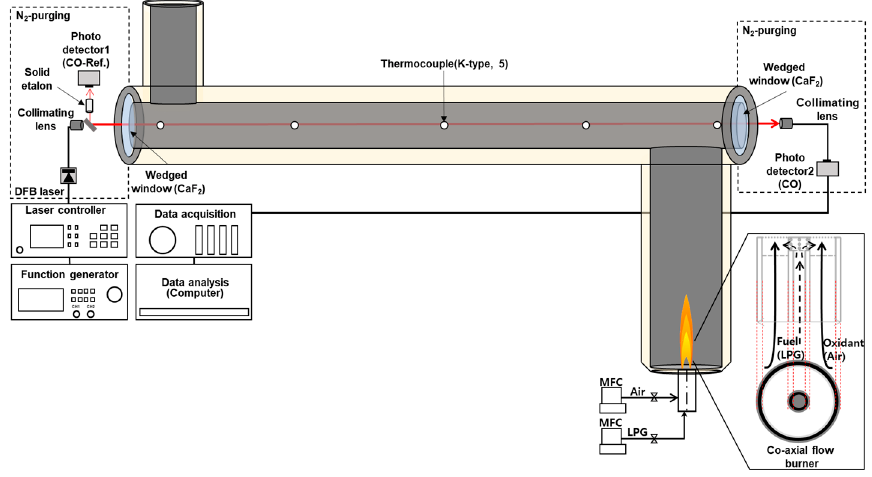
Figure 3. Schematic of the experimental setup of the combustion system with the co-axial burner.